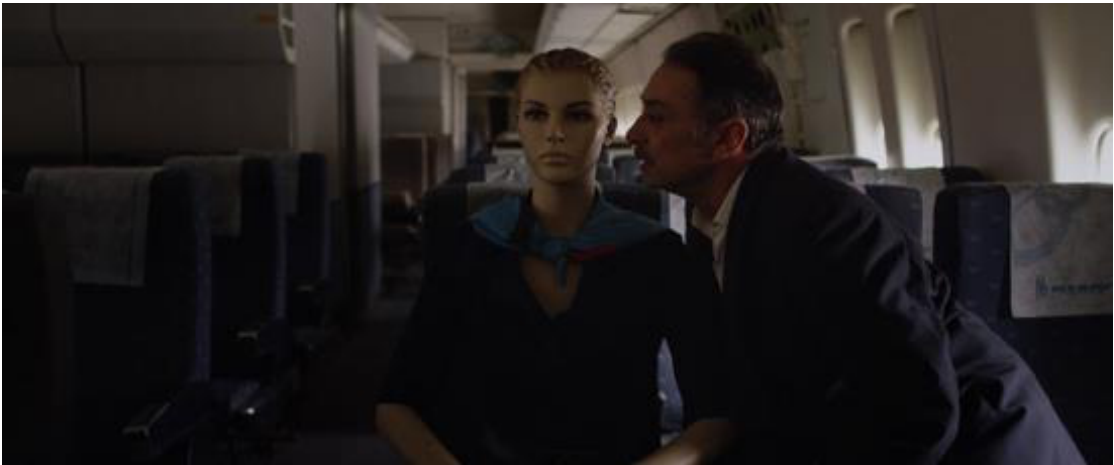
Figure 2. Naeem Mohaiemen, still from Tripoli Cancelled , 2017, digital video (color, sound), 95 min. © 2017 Naeem Mohaiemen. Courtesy of the artist and Experimenter, Kolkata.